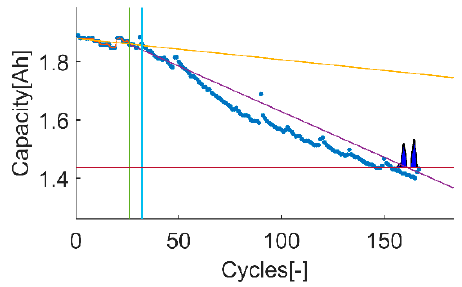
Figure 13. Time-instant figure of test 1 on t 17 .